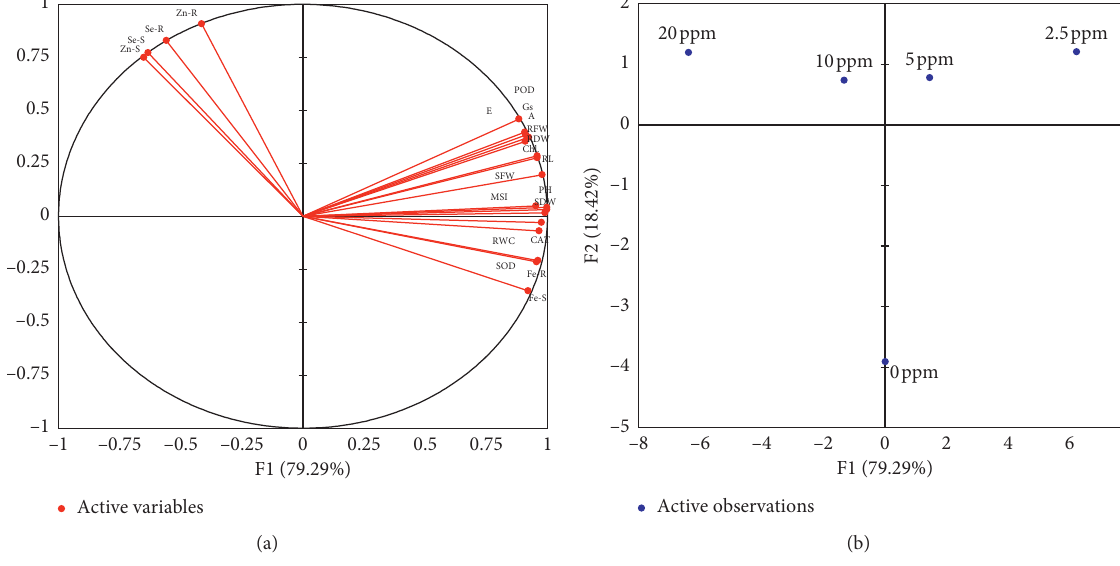
Figure 3: Principal component analysis of variables (parameters observed A) and observations (treatments applied B). PH: plant height, SFW; shoot fresh weight, SDW: shoot dry weight, RDW: root dry weight, RFW: root fresh weight, E: transpiration rate, A: photosynthetic rate, Gs: stomatal conductance, Chl.: chlorophyll (SPAD) contents, RWC: relative water contents, MSI: membrane stability index, Se-R: selenium in roots, Se-S: selenium in a shoot, SOD: sodium dismutase, CAT: catalase, POD: peroxidase, Zn-S: Zn in a shoot, Zn-R: Zn